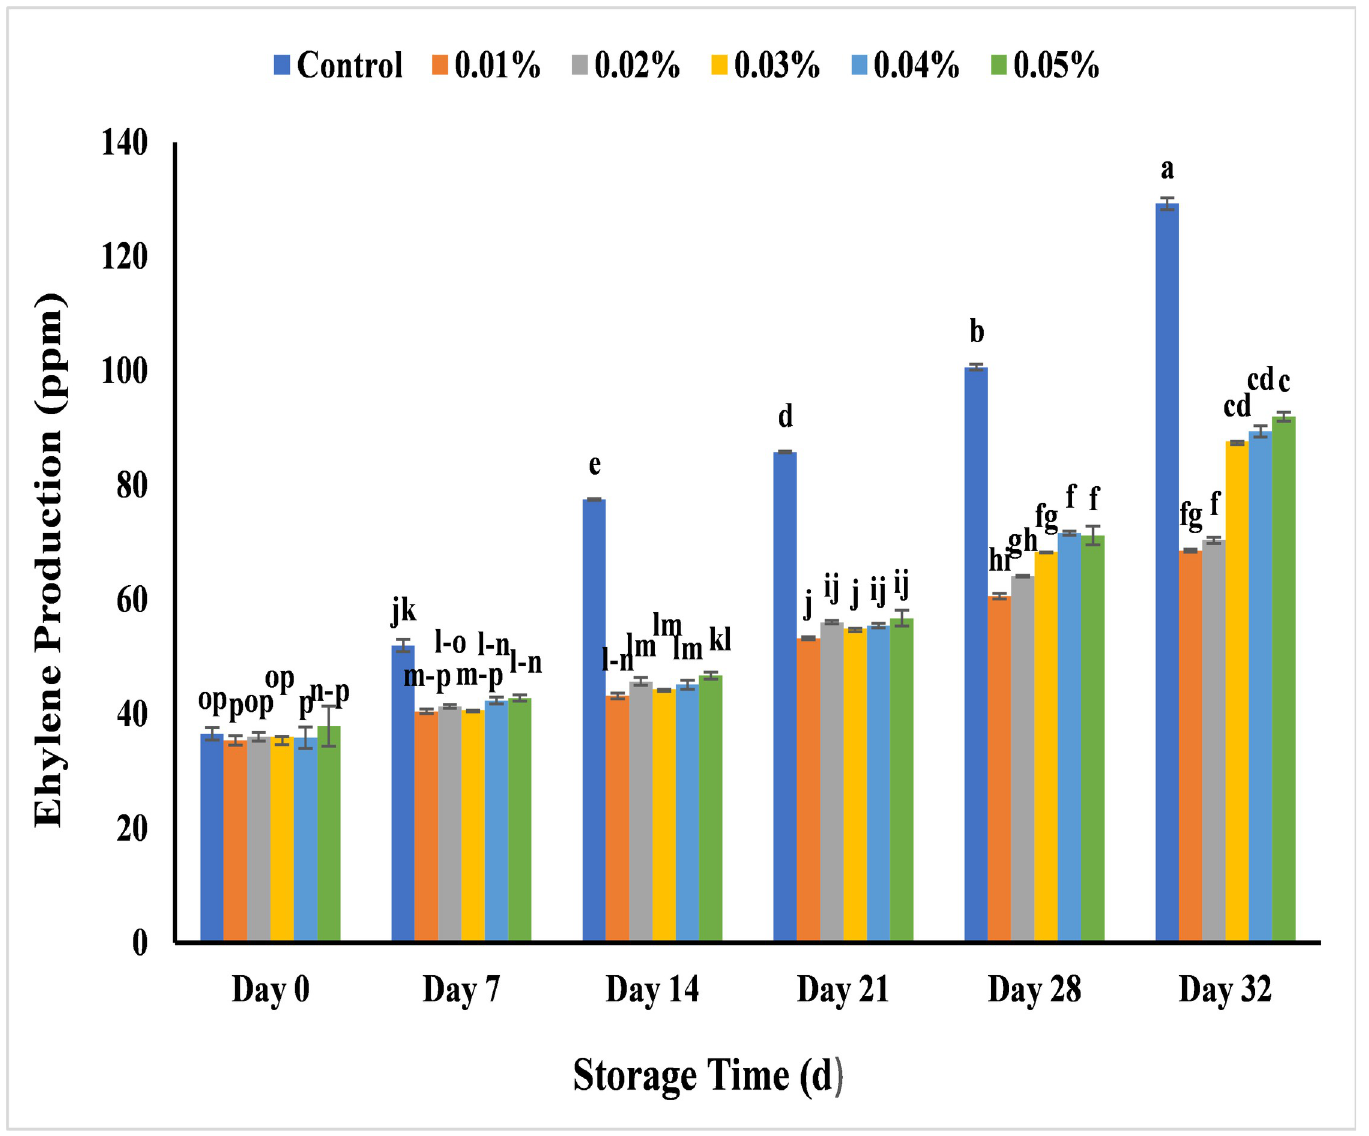
Fig 22. Effect of various AgNPs concentration (T0 = control, T1 = 0.01%, T2 = 0.02%, T3 = 0.03%, T4 = 0.04%, T5 = 0.05%) on ethylene production in Cavendish banana (BASRAI) during 32 days of storage.